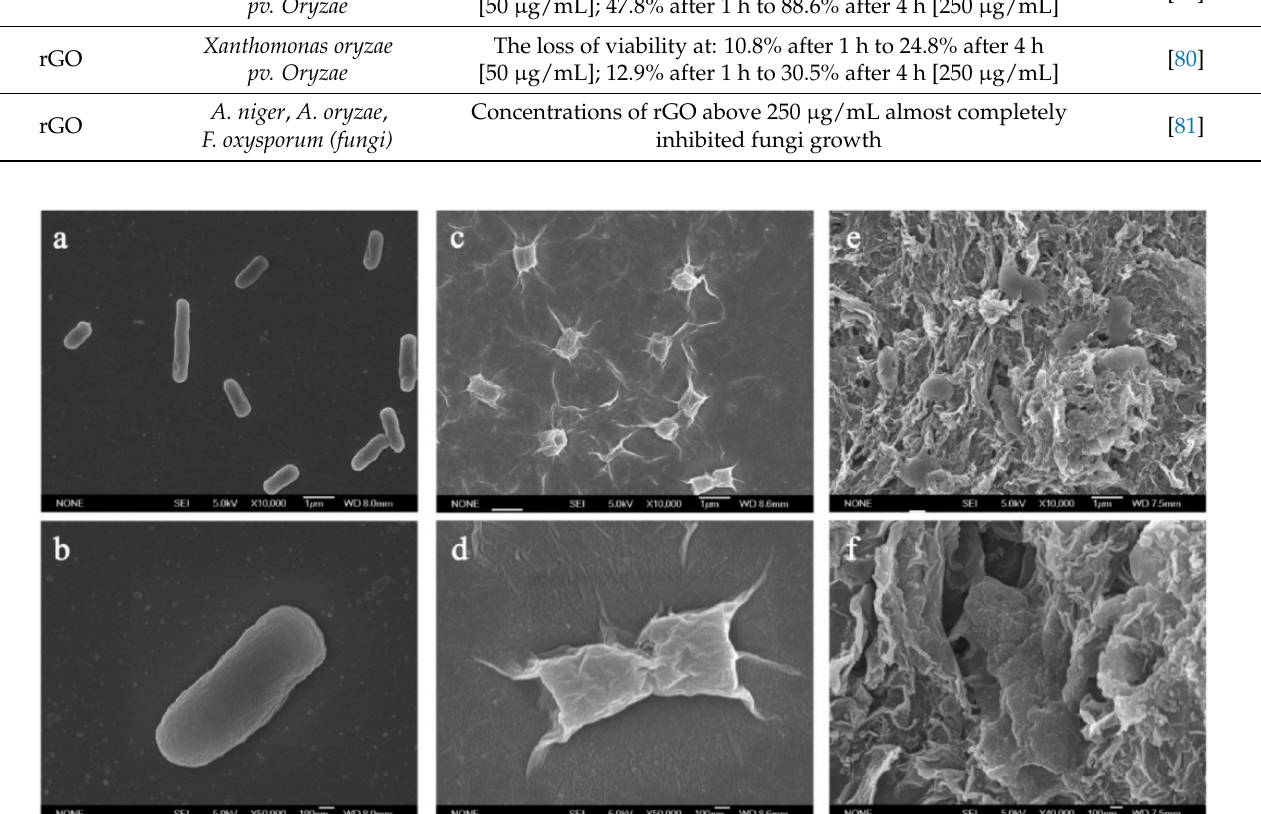
Figure 4. SEM images of E. coli bacteria in ( a , b ) saline solution, ( c , d ) in GO dispersion (40 µg/mL) , ( e , f ) in rGO dispersion (40 µ g/mL) after 2 h incubation. Reprinted with permission from [75]. ( e , f ) in rGO dispersion (40 µg/mL) after 2 h incubation. Reprinted with permission from [75] . Cop- Copyright 2011 American Chemical yright 2011 American Chemical Society.